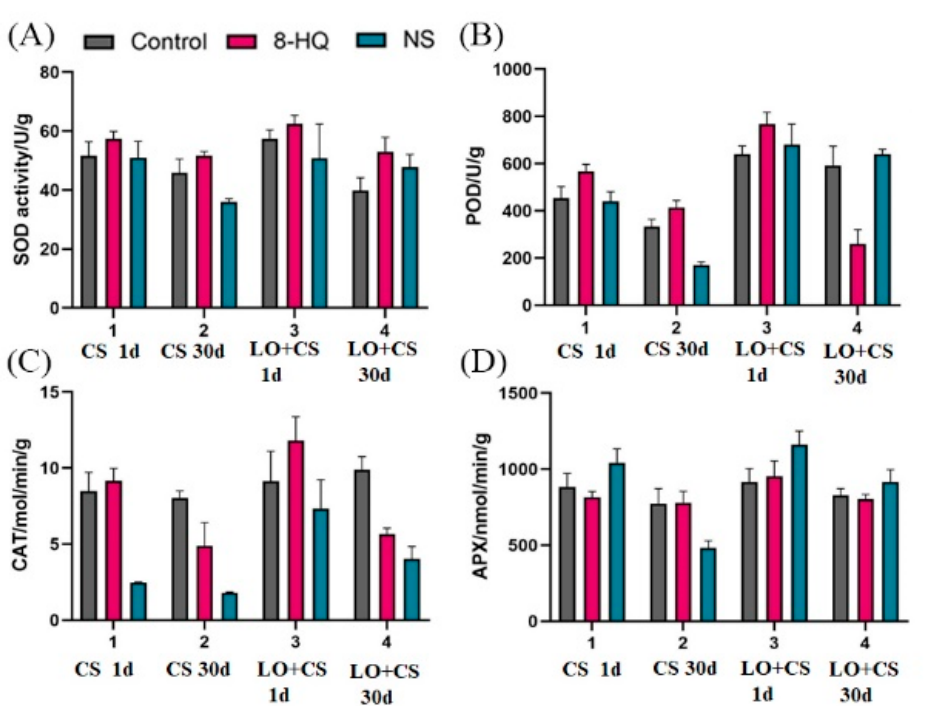
Figure 6. The protective enzyme activities of cut flowers on day 1 and day 30 after two pre-treatment solutions and storage methods. ( A ) SOD activity; ( B ) POD activity; ( C ) CAT activity; ( D ) APX activity. Values are expressed as the mean ± SD of three analyses. The vertical bar represents the standard deviation of the means.